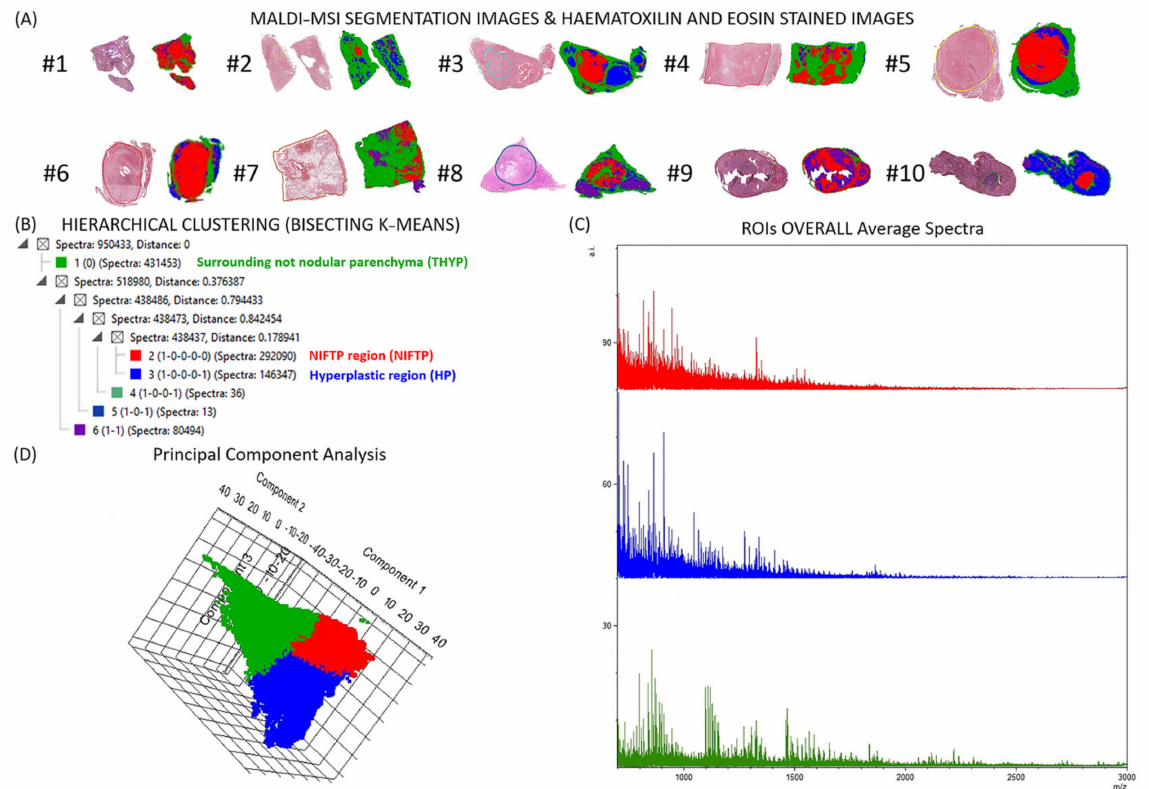
Figure 1. ( A ). Molecular maps obtained from MALDI–MSI compared to the annotation of NIFTPs from the expert pathologists. ( B ). Bisecting K-Means segmentation cluster tree of the tissue, based on the proteomic data, allowed the distinction of NIFTPs (red) from hyperplastic regions (HP, blue) and surrounding non-nodular thyroid parenchyma (THYP, green). ( C ). Average spectra of these three different regions. ( D ). Unit variance principal component analysis (PCA) score plot of the individual